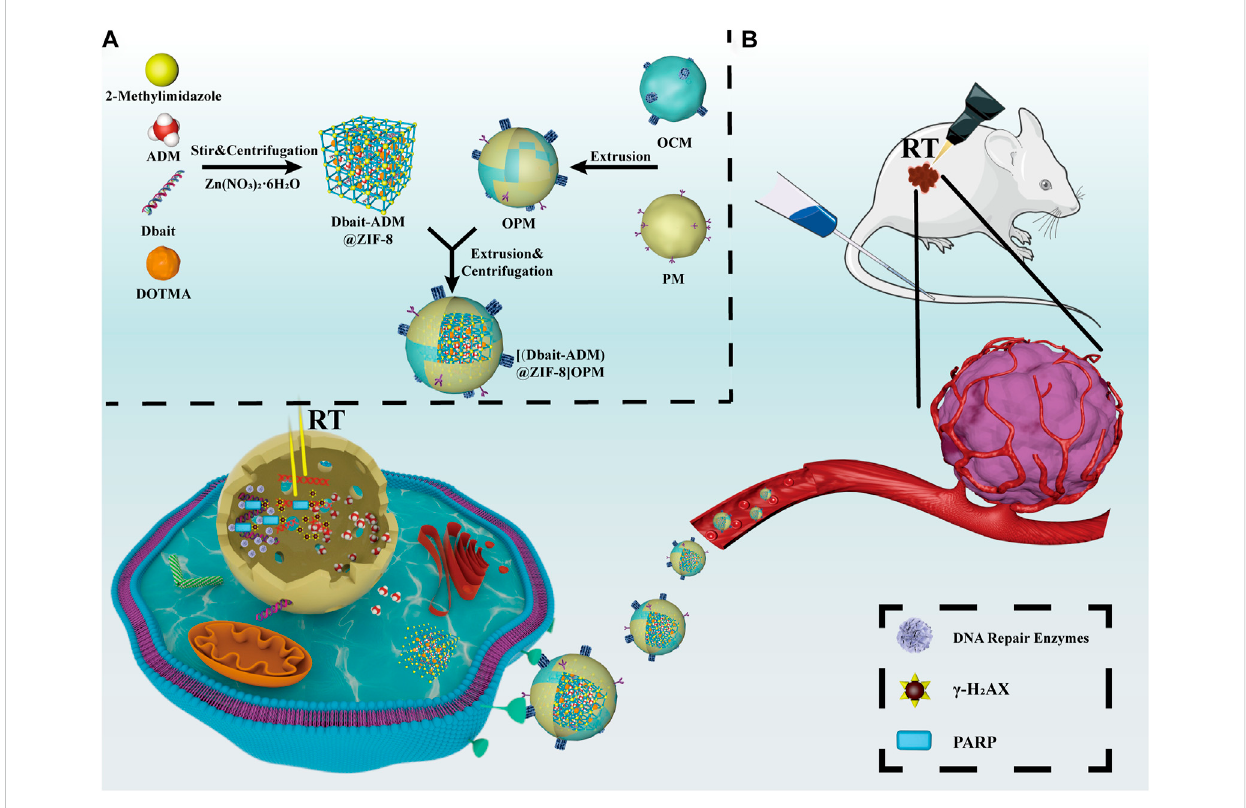
FIGURE 1 Schematic diagram of the synthesis and mechanism of action of [Dbait-ADM@ZIF-8]OPM. (A) Overview of the synthesis steps of [Dbait-ADM@ZIF- 8]OPM. (B) [Dbait-ADM@ZIF-8]OPM targets SaOs-2 cells by binding to a receptor expressed on the cell membrane. Once Dbait is released into the nucleus, under RT conditions, it leads to a long-term defect in the repair of DSBs that kills OS in concert with